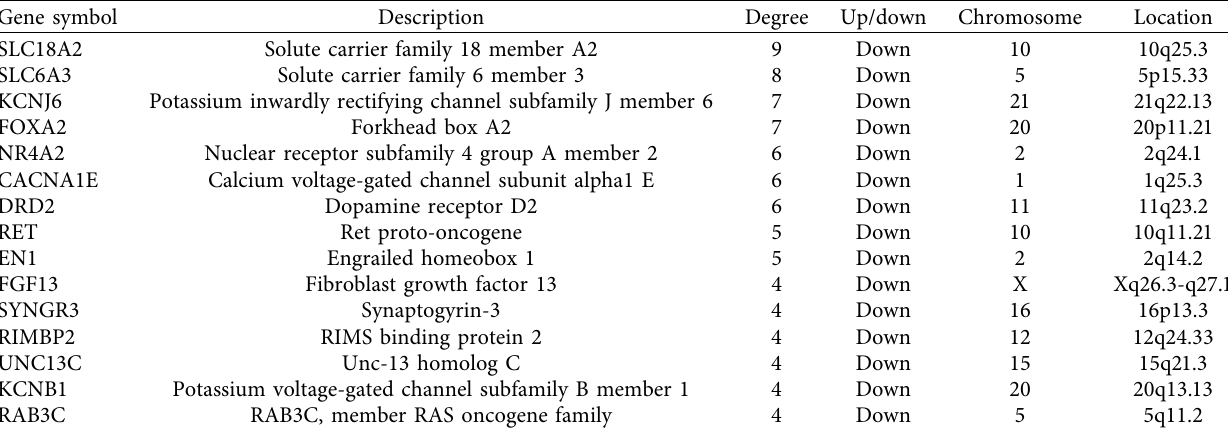
Figure 4: PPI network and the most signifcant module of DEGs. (a) Te PPI network of DEGs was constructed using Cytoscape with 49 nodes and 69 edges. Te size and color of the circle indicate the node degree. (b–e) Te four most signifcant modules obtained from the PPI network. DEGs, diferentially expressed genes; PPI, protein-protein interaction. Table 4: Te information of the top 15 hub genes.